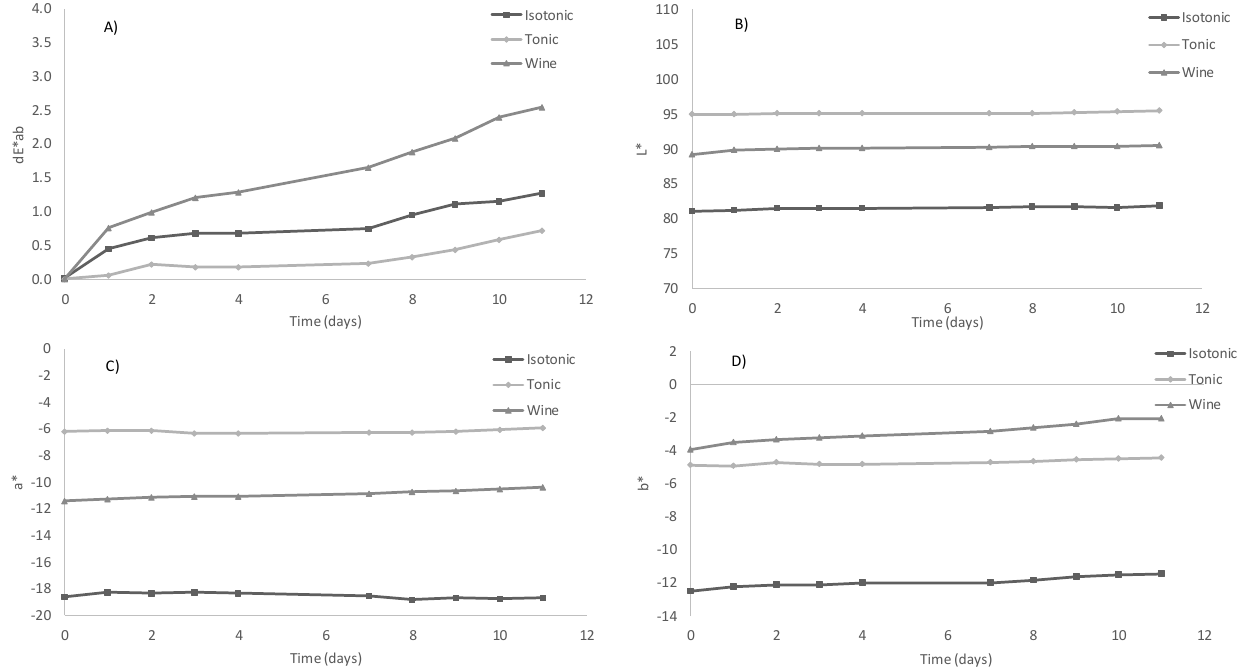
Figure 5. Changes in the colour indexes of the isotonic beverage, the tonic beverage, and the wine pigmented with the C-PC extract during a short cold-storage period. The plotted values are the means of the triplicate tests. Graphs show changes in ∆ E*ab ( A ), L* ( B ), a* ( C ), and b* ( D ).